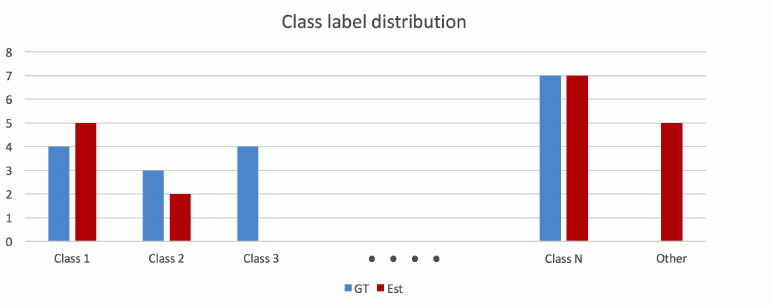
Figure 13. Abstract ground truth and estimated class label